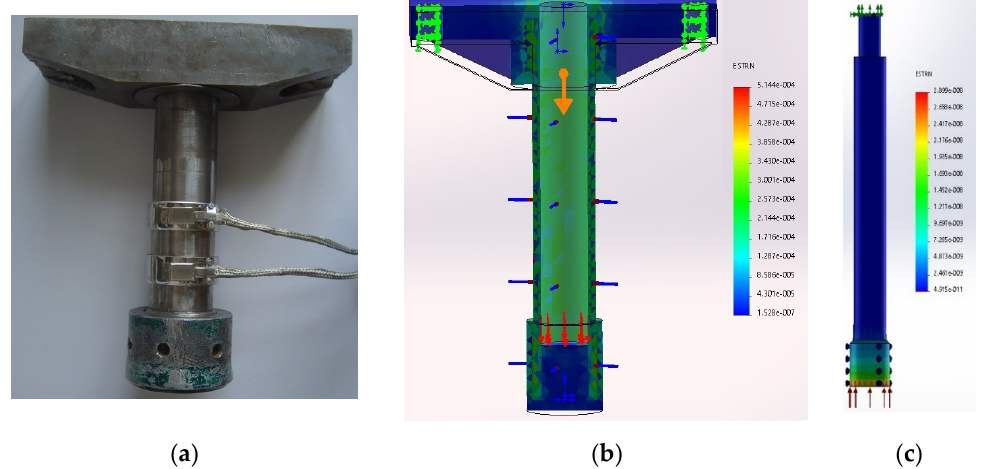
Figure 2. Research apparatus for measuring forest biomass compaction with an installed compacting tube: ( a ) compacting tube; ( b ) analysis of the construction of a prototype compacting tube; ( c ) analysis of the structure of the compacting head piston.